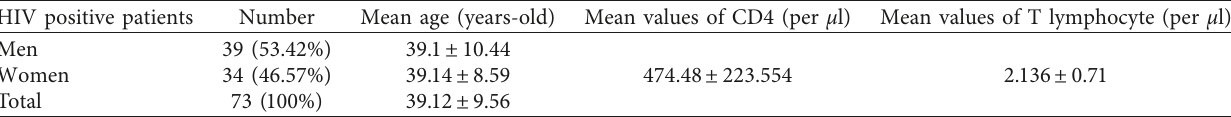
Table 2: The demographic data of HIV-positive participants.